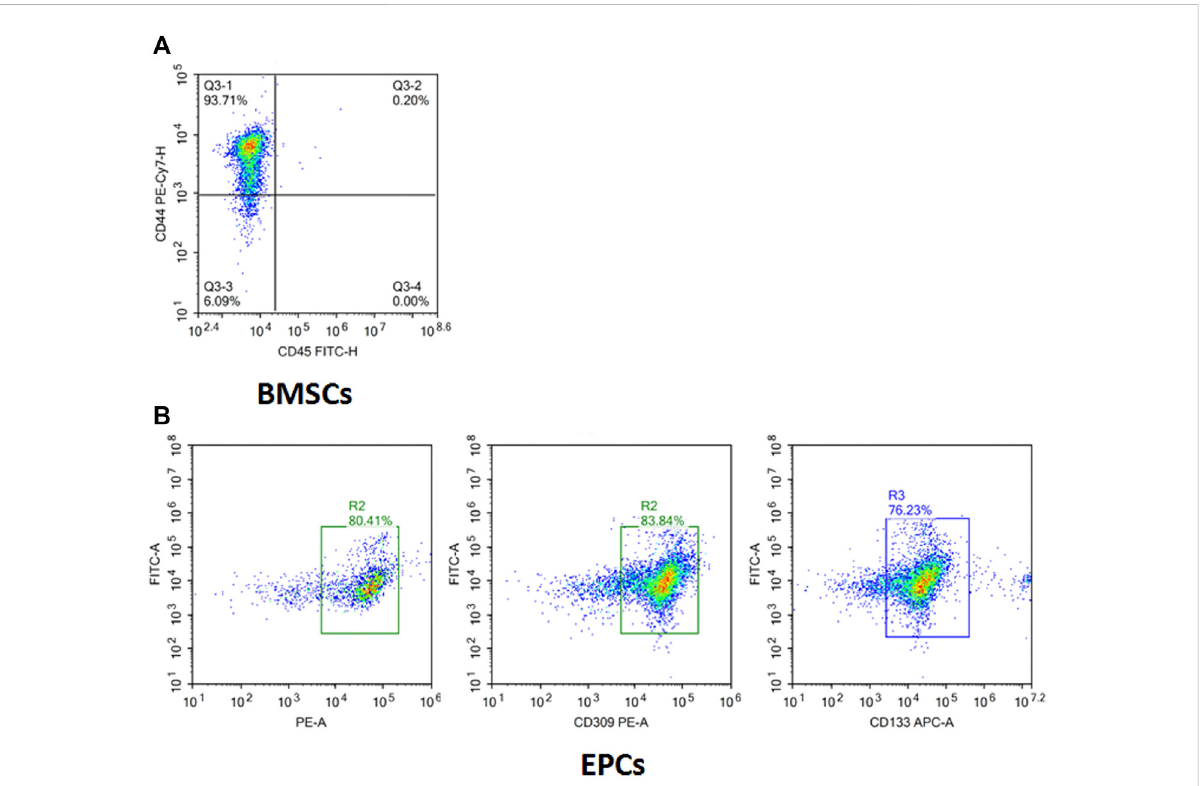
FIGURE 5 Surface markers of isolated and cultured BMSCs and EPCs. (A) Isolated cells were CD44 + (93.71%) and CD45 + (0.2%) determined by fl ow cytometry analysis. (B) Isolated cells were CD34 + (80.41%), CD309 + (83.84%), and CD133 + (76.23%) determined by fl ow cytometry analysis.